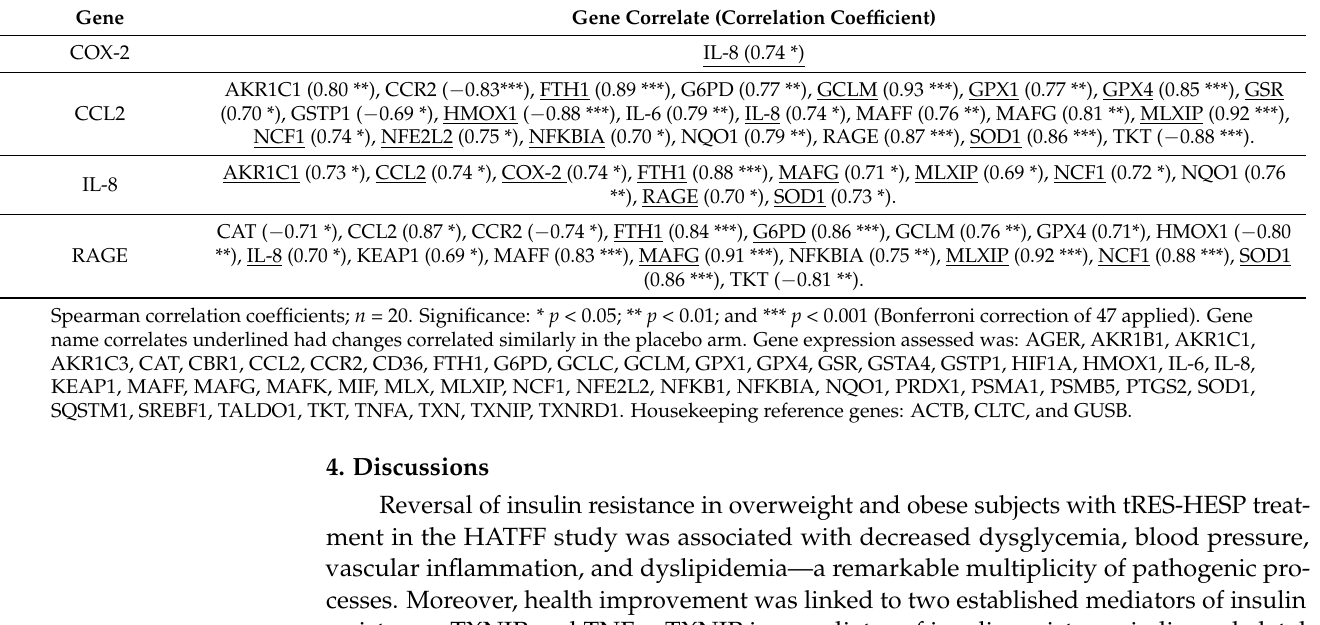
Table 3. Correlation of changes of peripheral blood mononuclear gene expression in highly overweight and obese subjects in the tRES-HESP and placebo treatment periods of the HATFF study. Gene Gene Correlate (Correlation Coefficient) COX-2 IL-8 (0.74